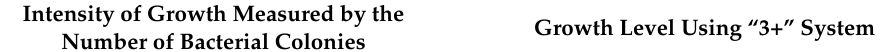
Table 1. Evaluation of microbial growth based on their ability to form colonies after exposure to CuO nanoparticles.